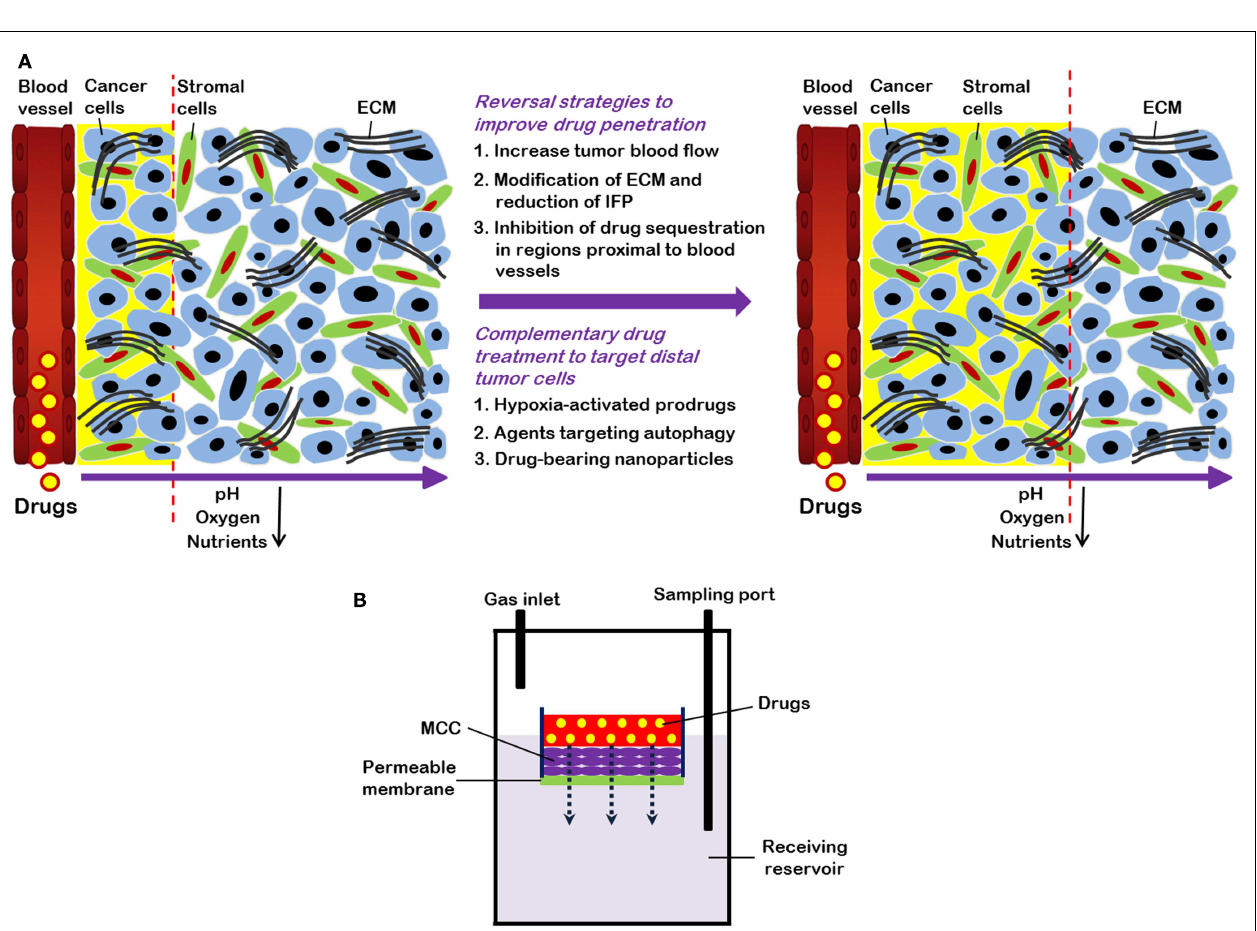
background and dashed lines) include increase of tumor blood flow, decrease of high interstitial fluid pressure (IFP), and modification of ECM. Combination treatment using “conventional” therapeutics together with drugs (e.g., hypoxia-activated pro-drugs and agents targeting autophagy) that are able to specifically target cells distant from vasculature also have potential to improve therapeutic efficacy. (B) Schematic representation of multilayered cell cultures (MCCs) to quantify drug penetration. A drug is first added into the small compartment above the MCC. After its passage from the semi-liquid media through the MCC, drug is sampled from the receiving compartment below the MCC and